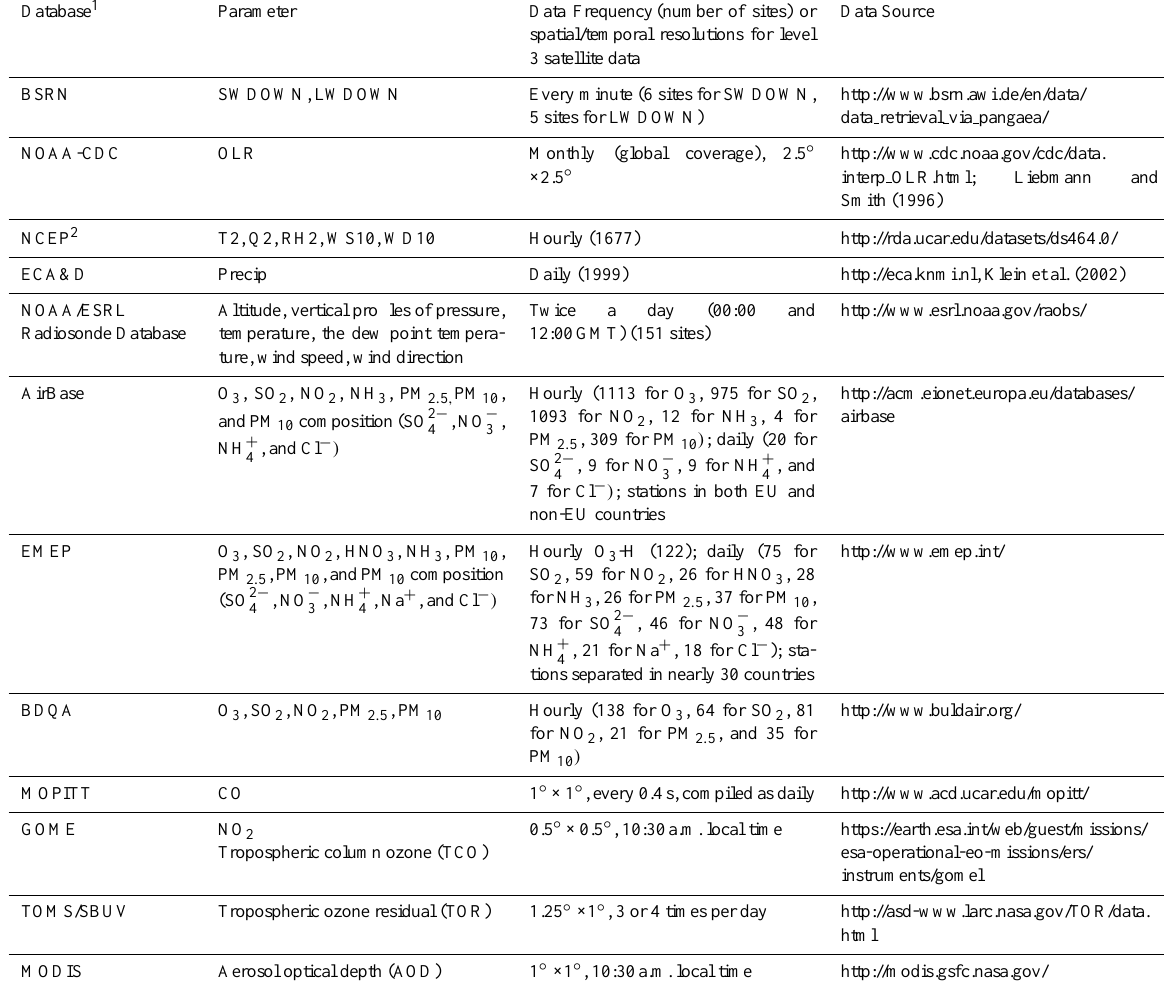
Table 3. Parameters and associated observational database included in the model